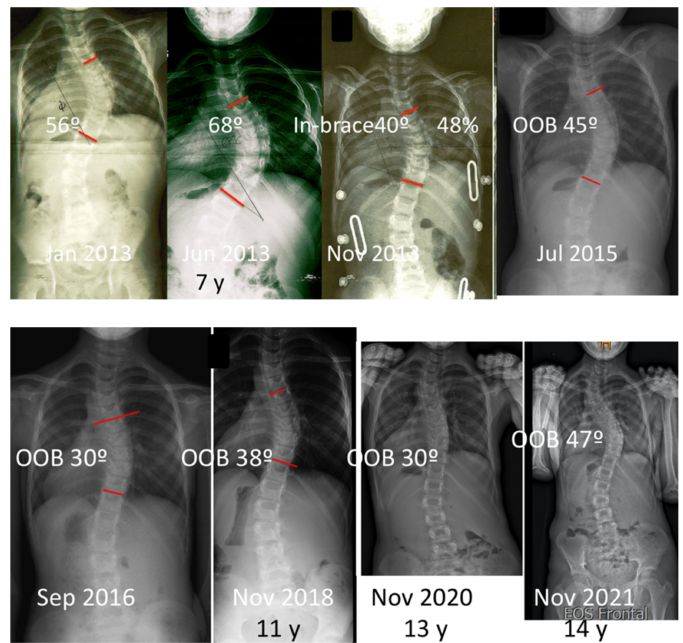
Figure 6. Girl treated with full-time brace, initiating the treatment at 7 years of age with a 68 ◦ thoracic scoliosis. With a 48% in-brace correction in her first brace she showed a good response until 10 years with a scoliosis of 30 ◦ . She was followed until 12 years of age still with a scoliosis of 30 ◦ . Next control at 13 years, she was still stable with 30 ◦ , but had developed a more relevant proximal curvature (after closing this present study). Between 2020 and 2021 (not registered in this present study), she showed a deterioration, with the development of a proximal curve of 43 ◦ , forcing us to stop bracing and recommending her to undergo